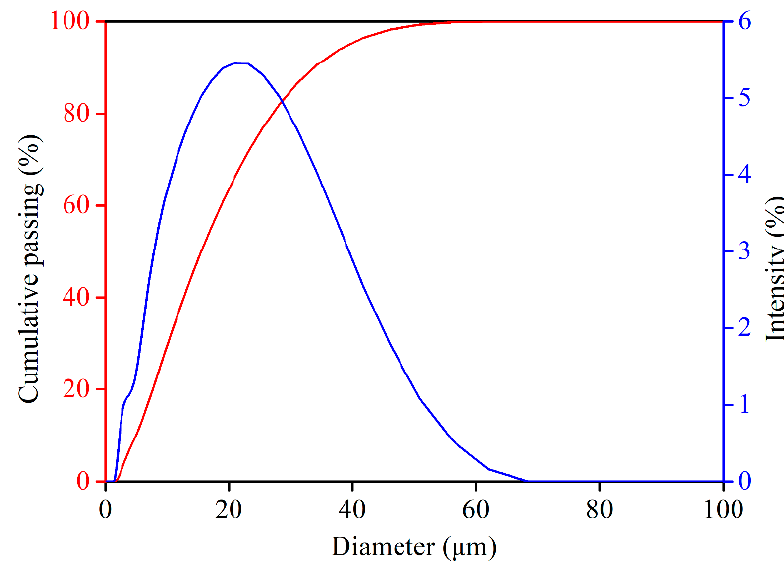
Figure 1. Particle size distribution of quartz sample.